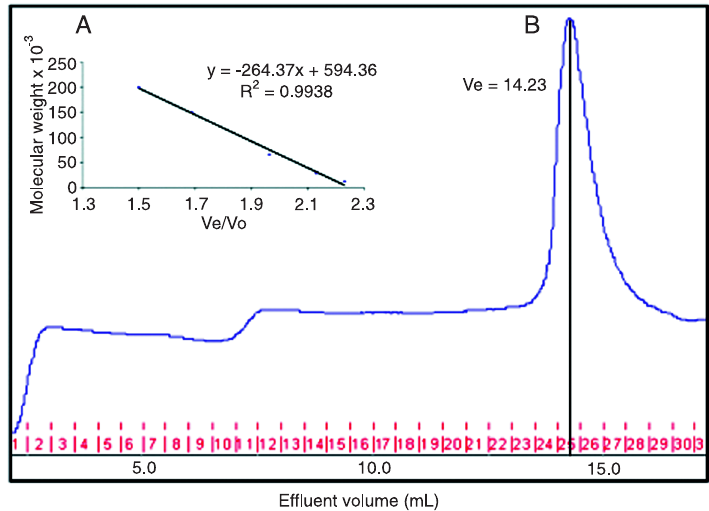
Figure 3. Determination of the molecular weight of GlnK-Sm. A , Calibration curve performed in Superdex 200. B , Gel filtration chromatography elution pro - file of GlnK-Sm. Column bed dimensions were 10 x 30 mm; bed volume was 24 mL; average particle size was 13 µm; load volume was 200 µL; flow rate was 0.4